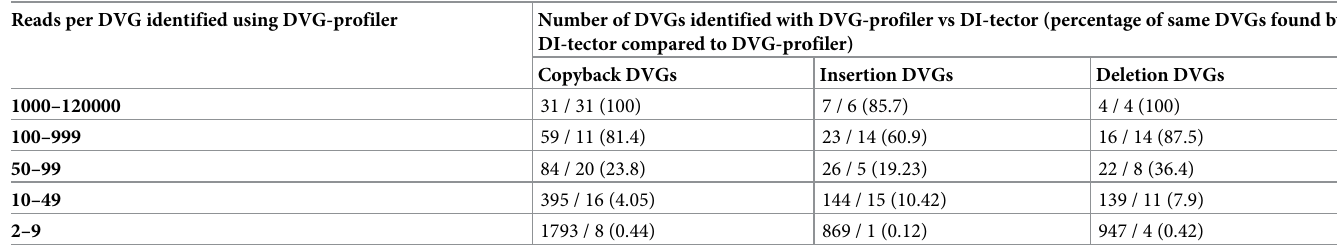
Table 6. Comparison of the sensitivity of DVG-profiler and DI-tector to detect copyback, deletion and insertion DVGs in virus #2. Reads per DVG identified using